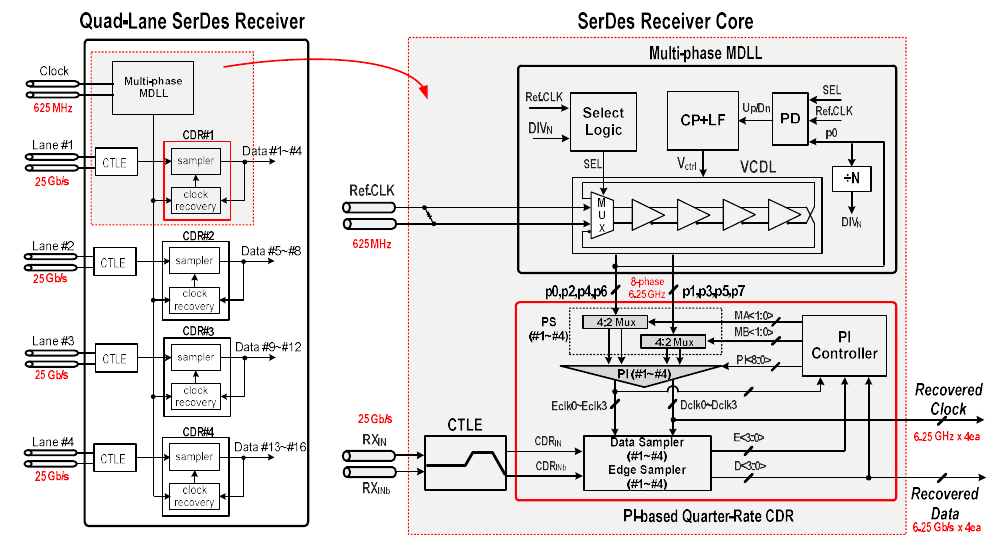
/ s quad-lane SerDes receiver Figure 3. Proposed 100 Gb/s quad-lane SerDes receiver architecture. Figure 3. Proposed 100 Gb